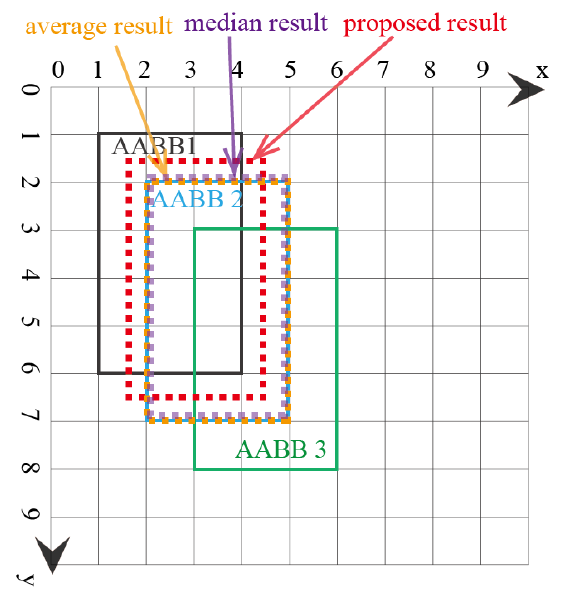
Figure 5. First example of fusing three similar